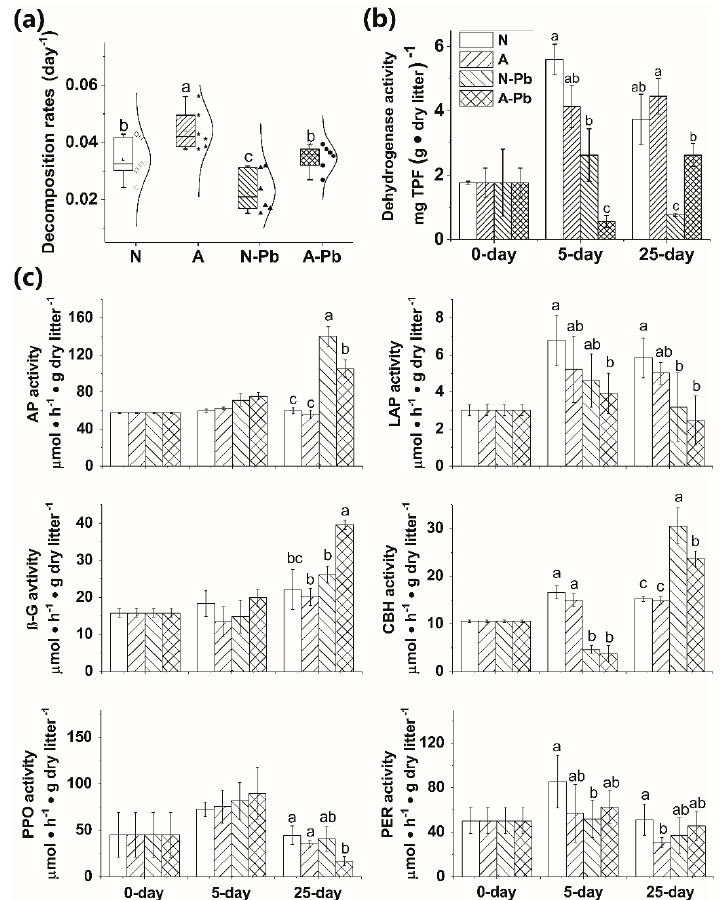
Figure 1. Decomposition rates of Pterocarya stenoptera leaf litter ( a ), associated dehydrogenase ( b ), and extracellular enzyme activities ( c ), after 25 days of incubation in the microcosms. Legend: N, natural light simulation group without Pb; A, artificial light at night (ALAN) simulation group without Pb; N-Pb, natural light simulation group with Pb; N-As, ALAN simulation group with Pb; AP, acid phosphatase; LAP, leucine-aminopeptidase; β -G, β -glucosidase; CBH, cellobiohydrolase; PPO, polyphenol oxidase; PER, phenol oxidase. Different lowercase letters on top of the bars denote significant differences ( p < 0.05) among the